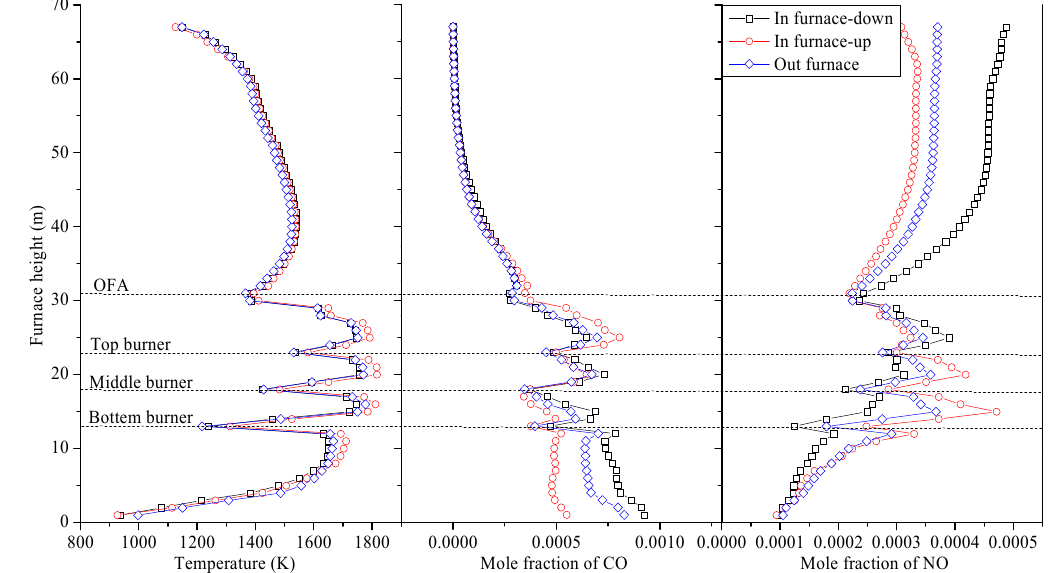
Figure 8. The average temperature and species concentrations along the height of furnace.